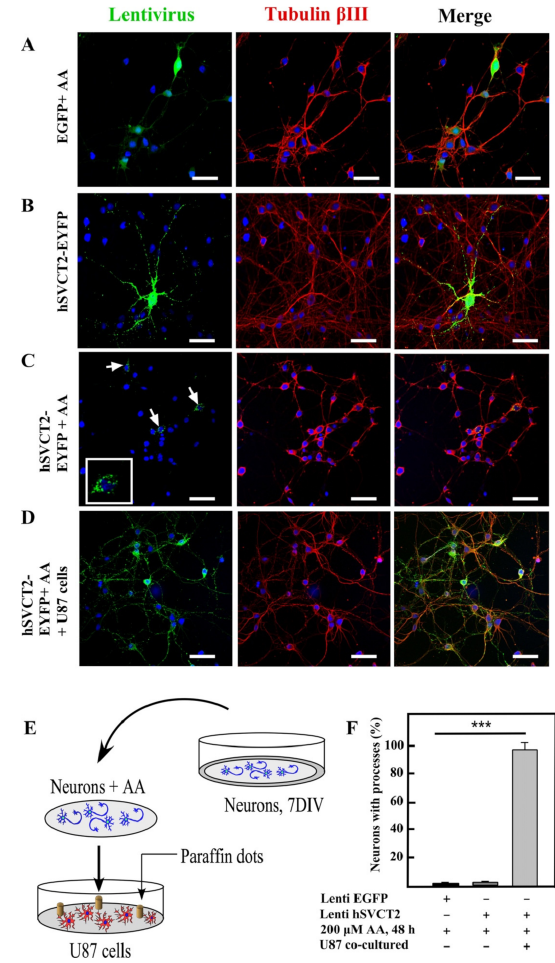
Figure 4. Astrocyte-like cells induced vitamin C recycling and maintain neurite processes in neu- rons overexpressing SVCT2 and treated with ascorbic acid. ( A – D ) Confocal microscopy analysis of hSVCT2wt-EYFP- or EGFP- overexpressing cortical neurons transduced for 48 h in vitro and incubated with anti-tubulin BIII (red). The cells were cultured in the absence or presence of ascorbic acid (AA). ( A ) EGFP-overexpressing cortical neurons treated with AA. ( B ) hSVCT2wt-EYFP-overexpressing cortical neurons. ( C ) hSVCT2wt-EYFP- overexpressing cortical neurons treated with AA. ( D ) hSVCT2wt-EYFP- overexpressing cortical neurons treated with AA and incubated with astrocytes-like cells (U87, recycling cells). ( E ) Scheme of the experimental procedure of co-culture between neurons and astrocytes. ( F ) Neurons cultured in different conditions. Quantification analysis of neurons with processes. The data represent the means ± SD of three experiments. *** p < 0.001. Scale bars in ( A – D ), 25 µ